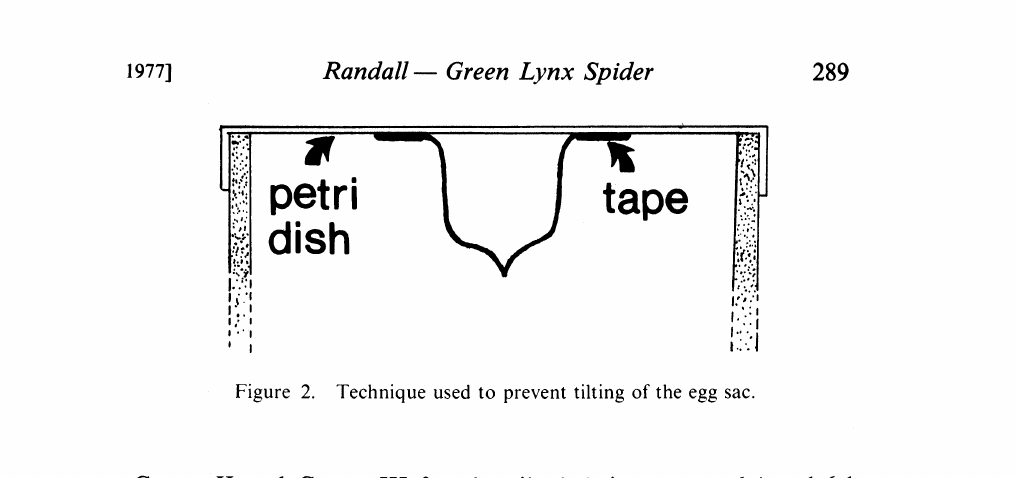
Figure 2. Technique used to prevent tilting of the egg